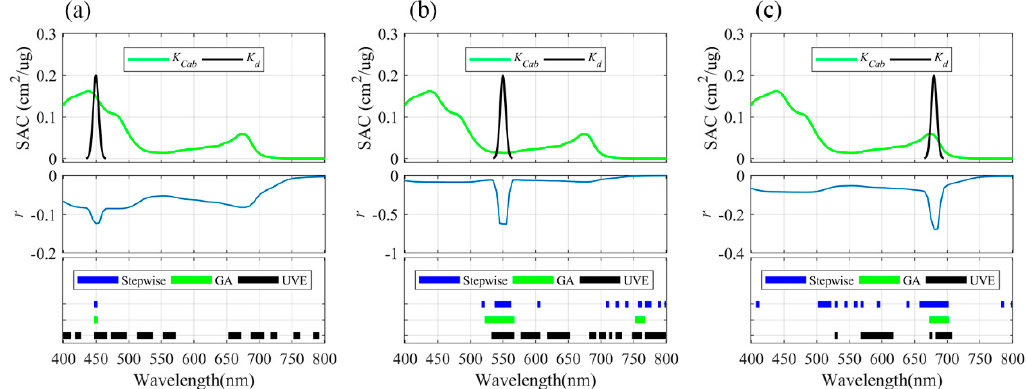
Figure 1. Bands selected in partial least squares regression (PLSR) models with three different variable selection/elimination approaches to estimate C d with different absorption peak locations: ( a ) 450 nm, ( b ) 550 nm, and ( c ) 680 nm. The absorption peak intensities (at absorption peaks) and half-widths shown were set to 0.20 cm 2 /ug and 10 nm, respectively.